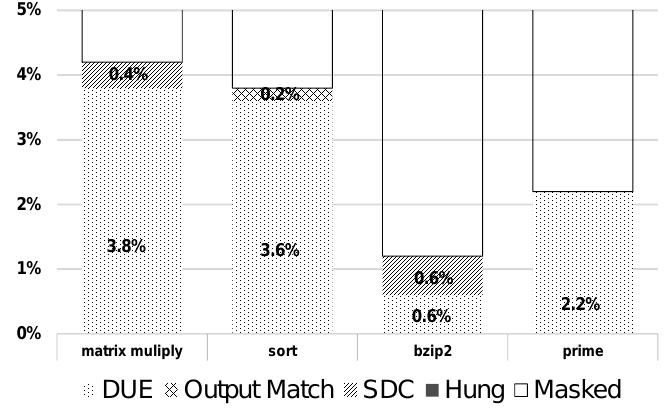
Figure 5. System failure results by fault